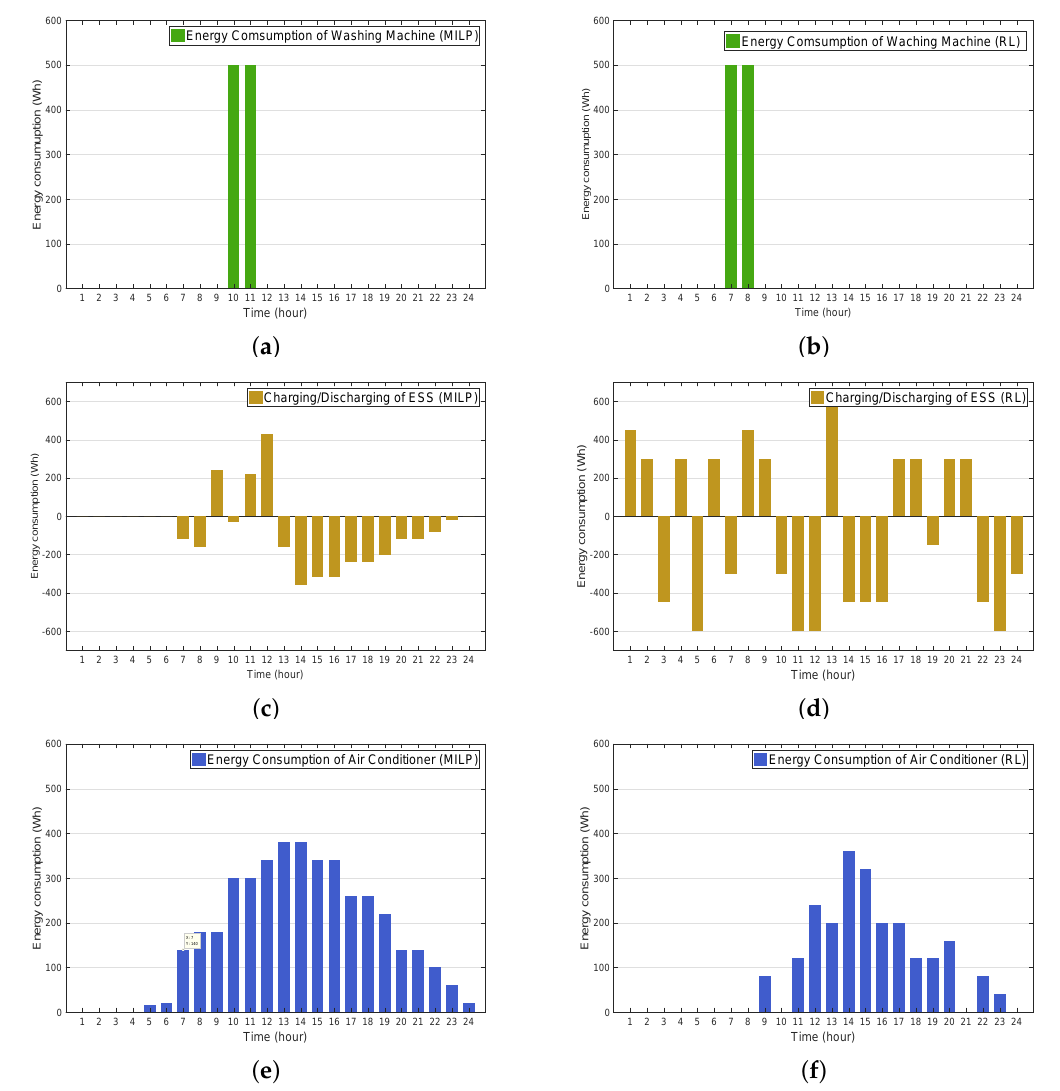
Figure 10. Comparison of energy consumption and charing/discharging energy between mixed-integer linear programming (MILP) and RL methods. ( a ) WM with MILP; ( b ) WM with RL; ( c ) ESS with MILP; ( d ) ESS with RL; ( e ) air conditioner (AC) with MILP; ( f ) AC with